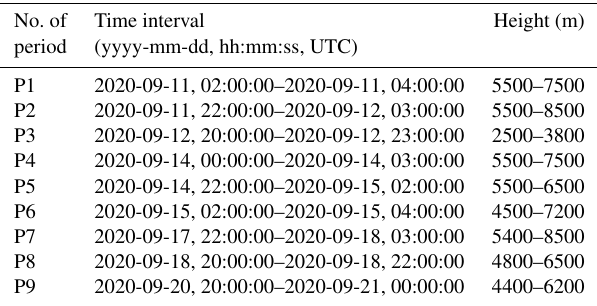
Table 1. The averaging time intervals and altitude ranges of selected BBA layers for the analysis of statistics. P1, P2 ..., P9 represent different time intervals in September 2020.